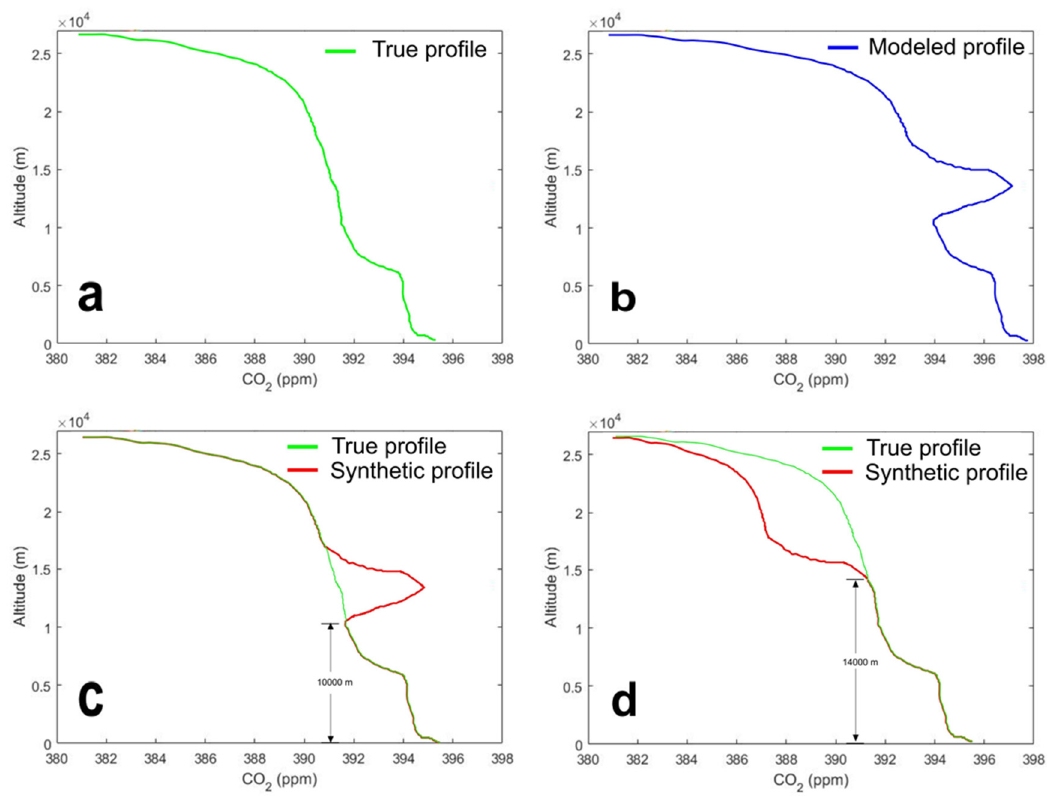
Figure 4. Depiction of the key elements of a thought experiment: ( a ) assumed true profile; ( b ) assumed modeled profile; ( c ) true and reconstructed profile assuming sampling up to 10 km; and ( d ) assumed true and reconstructed profile assuming sampling up to 14 km.